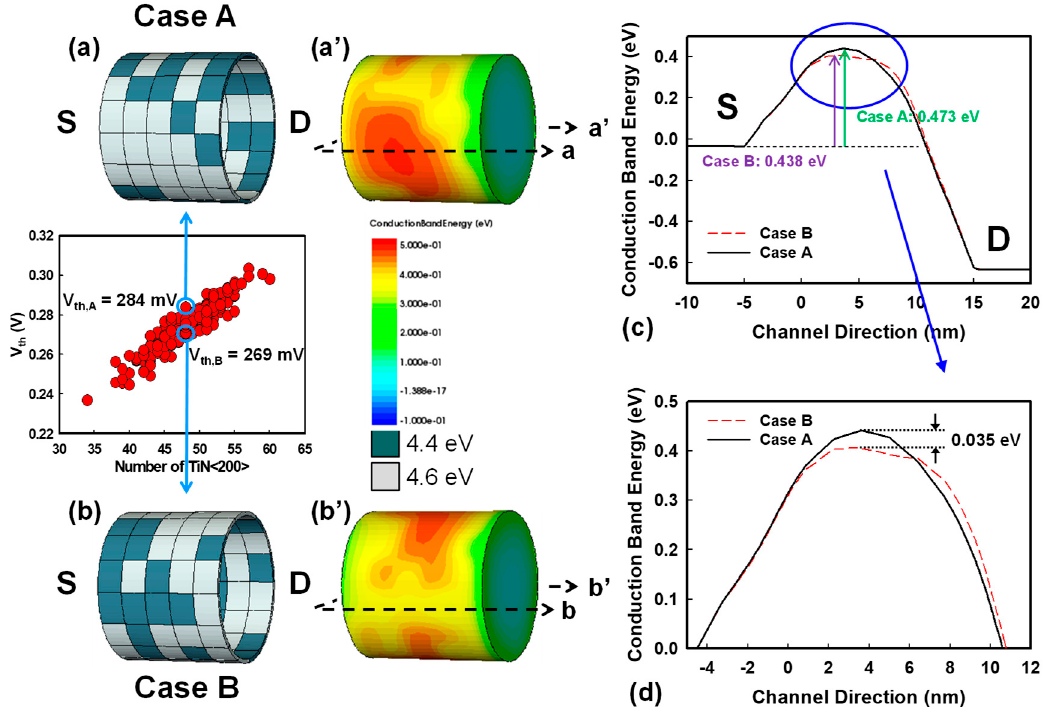
Figure 3. ( a )–( b ) The metal grain distribution of Case A and Case B that have the same number of WKs but di ff erent V th . For the metal gate, the green color represents low WKs, and the white color indicates high WKs. ( a’ , b’ ) The corresponding conduction band energy distributions in the channel region. The bias conditions are V D = 0.6 V and V G = 0 V. ( c ) The one-dimensional (1D) conduction band energy pro fi le, and ( d ) the zoom-in plot from the source side to the drain side of Case A and Case B. Case A has a higher barrier in the off-state, which leads to higher V th compared with Case B.